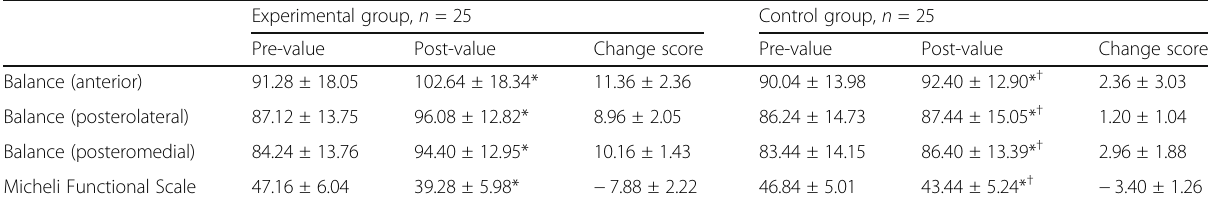
Table 2 The values of balance (cm) and Micheli Functional Scale (out of 100) Experimental group, n = 25